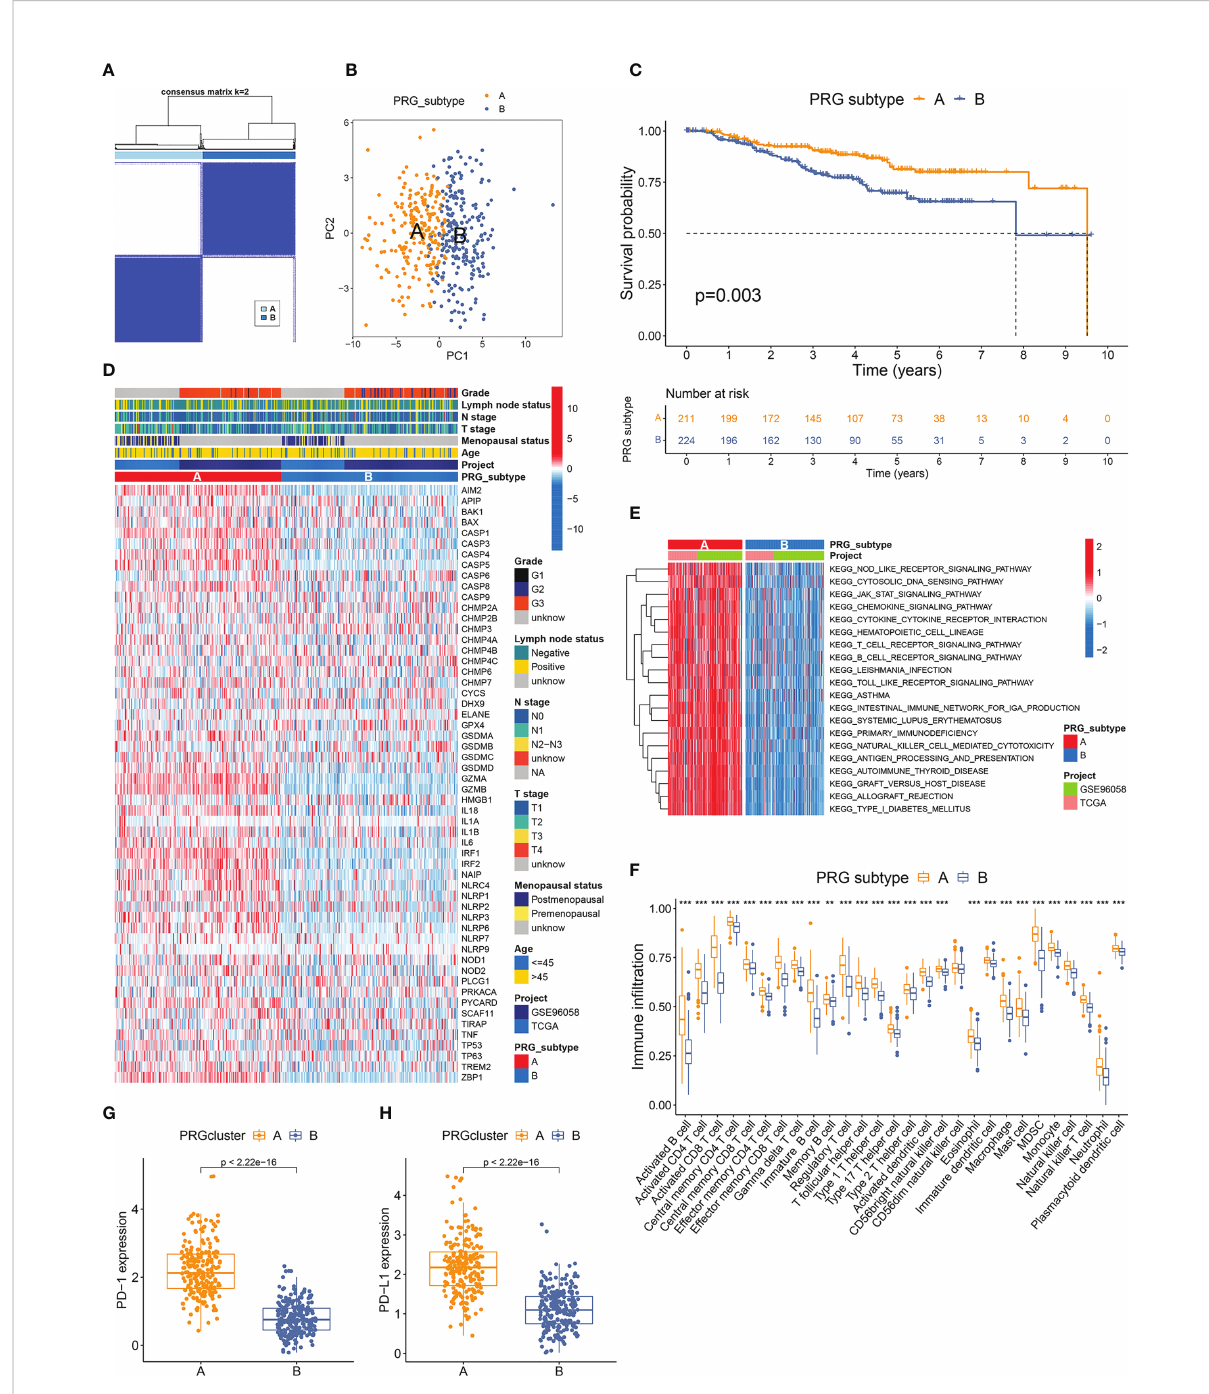
FIGURE 3 Classi fi cation and TME features of pyroptosis subtypes in TNBC. (A) Two pyroptosis-related subtypes and their correlation area de fi ned by consensus matrix heatmap. Fifty-six PRGs listed in Supplementary Table S2 are included in the subtype clustering analyses. (B) PCA analysis veri fi ed the remarkable differences in pyroptosis transcription pro fi les between two subtypes. (C) TNBC patients de fi ned as PRG subtype A exhibited signi fi cantly better OS compared to those from PRG subtype (B, D) Comparisons of PRG expression and clinicopathological features between two PRG subtypes. (E) GSVA canonical pathway analysis discovered PRG subtype A samples with dramatically higher enrichment in multiple immune-related pathways. (F) Twenty-seven immune cell types showed distinctly higher in fi ltration levels in the microenvironment of subtype (A, G, H) Expressions of PD-1 and PD-L1 were remarkably elevated in subtype A. ** p < 0.01, *** p <